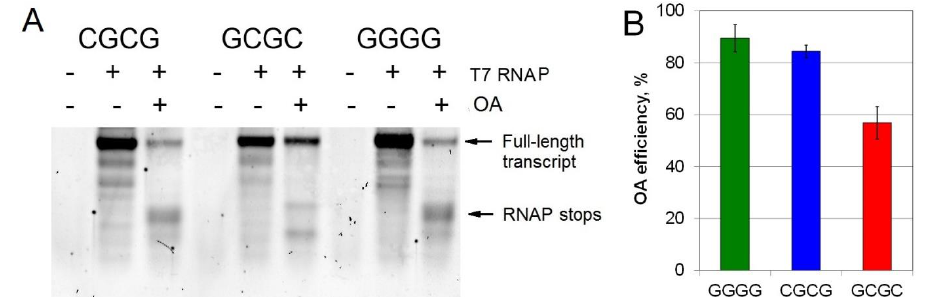
Figure 4. Run-off T7 transcription performed from the short double-stranded DNA templates containing a single tetranucleotide OA binding site, CGCG, GCGC or GGGG. ( A ) Separation of the transcription products in a 10% denaturing polyacrylamide gel. The arrows indicate the full-length RNA transcript and RNAP stop points in the presence of OA. ( B ) The efficiency of transcription inhibition by OA is calculated as percentage of (R F – R OA )/R F , where R F and R OA are the amount of the full-length RNA product produced in the absence and presence of OA, respectively.